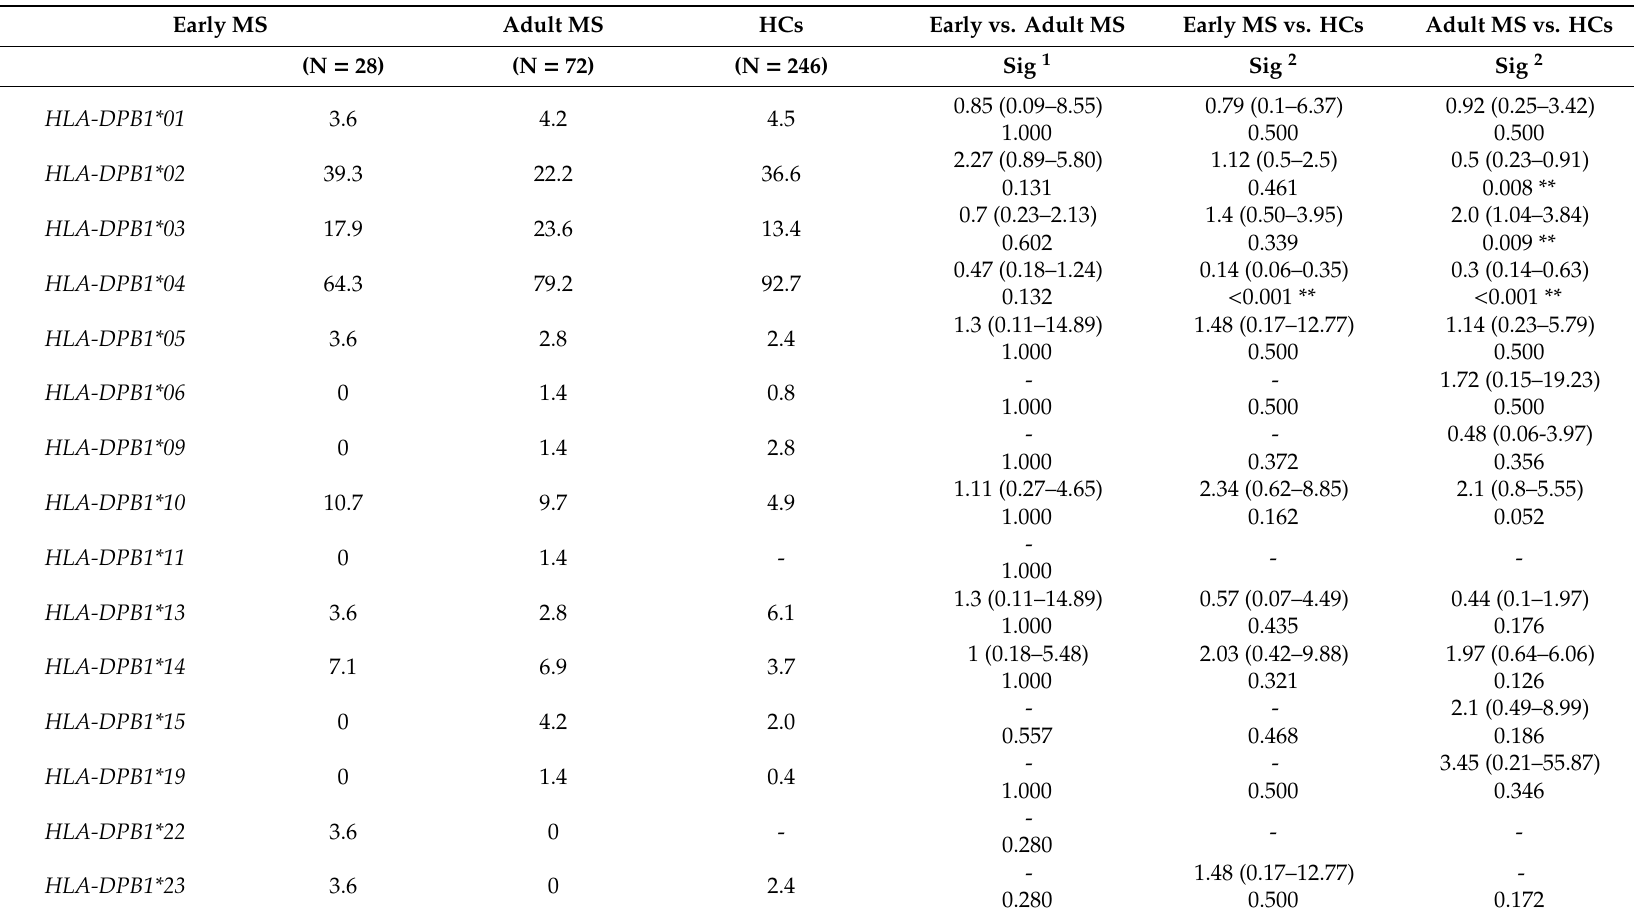
Table 2. HLA-DPB1 Allele Frequencies Among Di ff erent Age of Multiple Sclerosis (MS) Onset Groups of